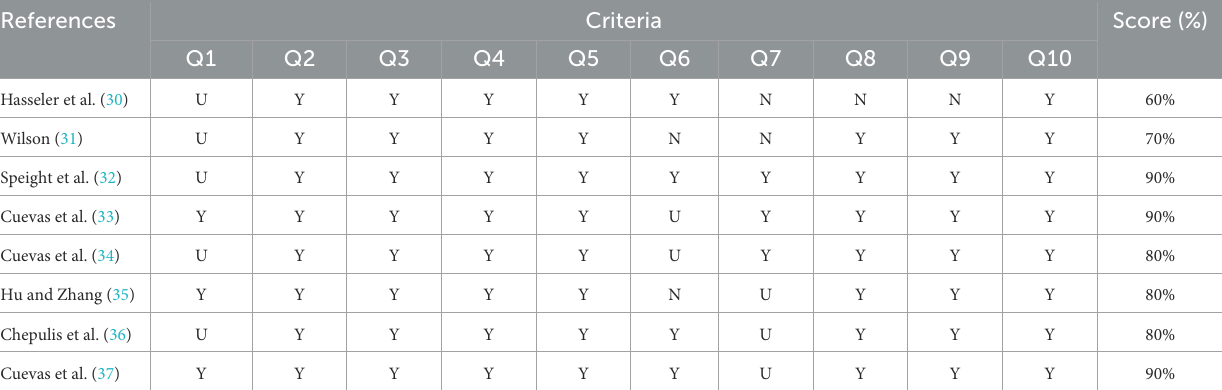
TABLE 2 Quality